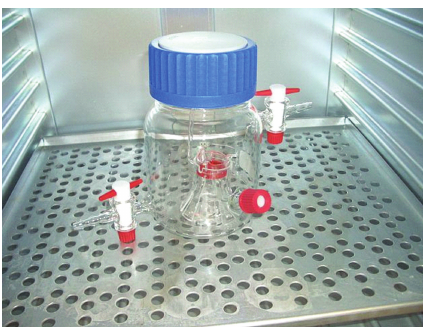
Figure 1: Modified glass flask for exposure of cells to volatile metal(loid) species. Cells were grown on permeable membranes. Exposure occurred through the